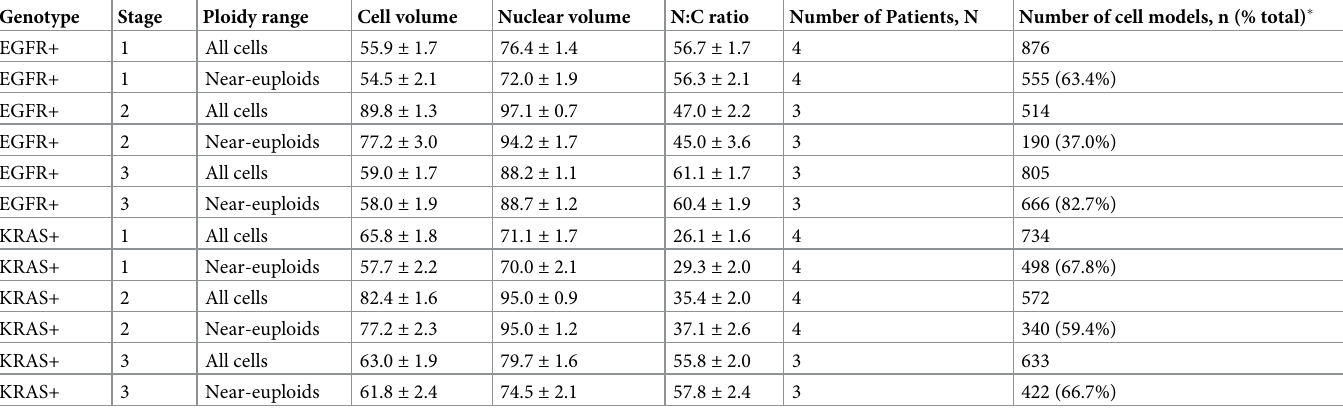
Table 4. Percentages of abnormal cell volumes, nuclear volumes, and N:C ratios vs. stage, genotype, and DNA content.